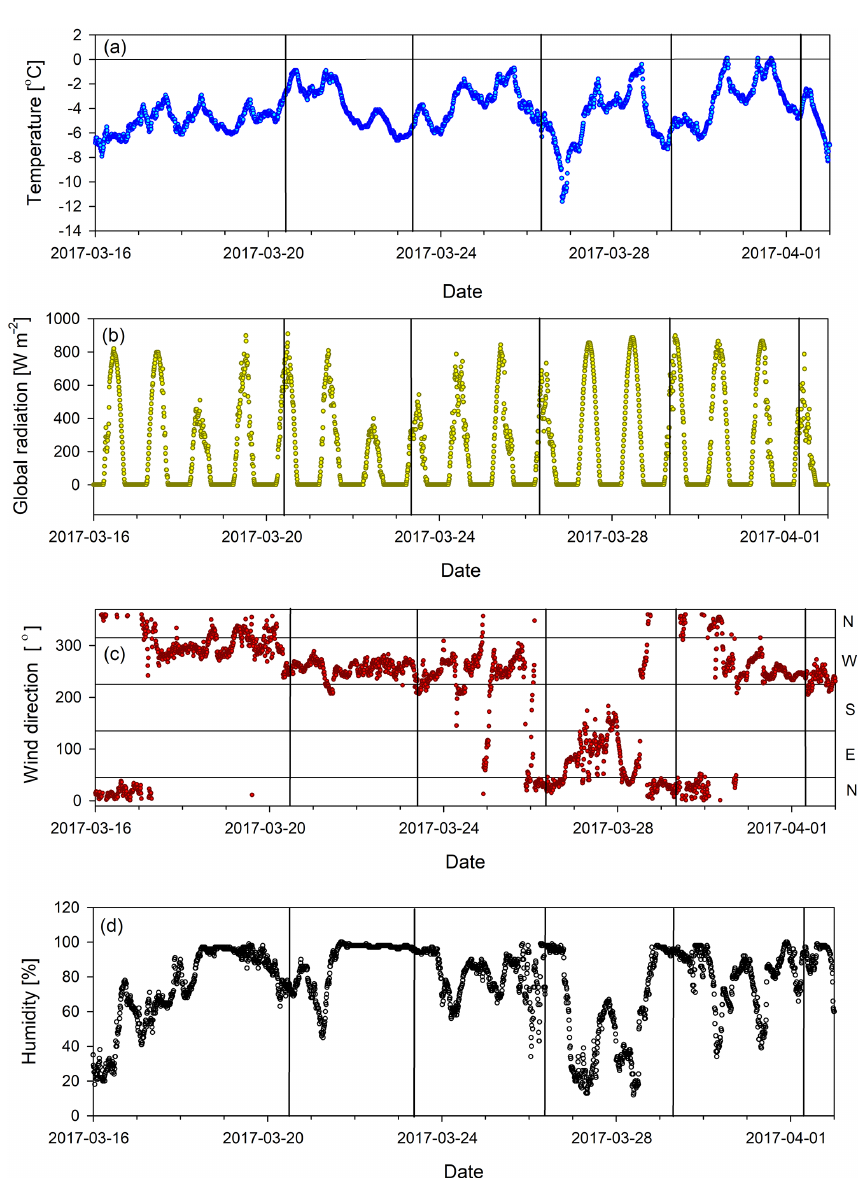
Figure 1. Meteorological data measured at Sonnblick station during the sampling: (a) temperature, (b) global radiation, (c) wind direction, (d) relative humidity. Vertical lines represent the sampling time. Note the wind direction change in the period preceding the sampling on 29 March